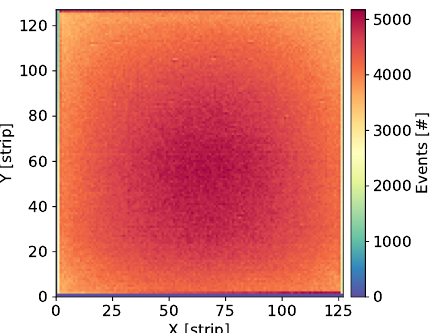
Figure 19. Standard GEM detector E with copper foils. Map of cumulative counts of reconstructed events for detector bias voltage of